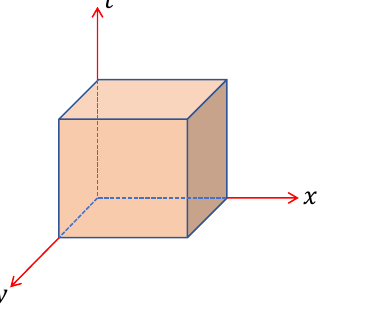
Figure 4. The data structure represented by HGSTCode.